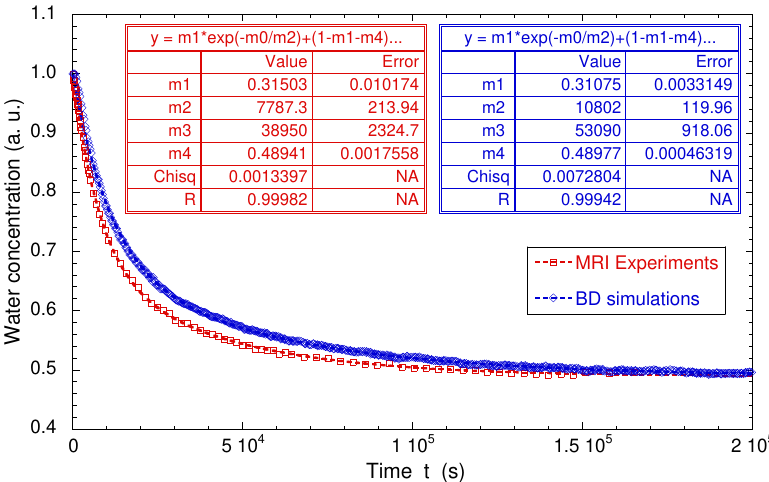
Figure 17. Direct comparison of the time evolutions of the measured and simulated numbers of confined water molecules. Experimental and numerical data are fitted by a biexponential law: f ( t ) = m 1 exp ( − t / m 2 ) + ( 1 − m 1 − m 4 ) exp ( − t / m 3 ) + m 4 , where m i are constants. Reprinted with permission from [29]. Copyright (2018) American Chemical